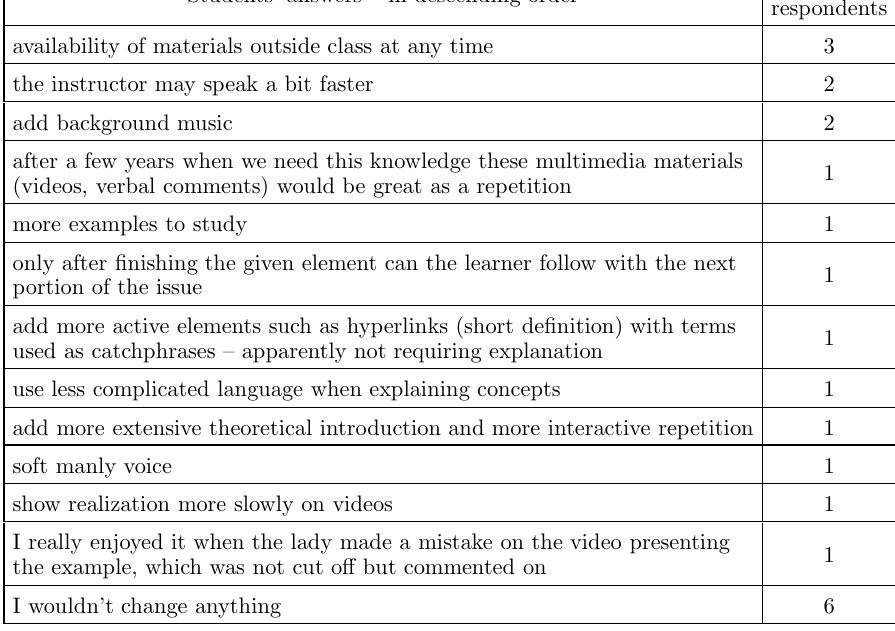
Table 5. Distribution of students’ answers to the open-ended question “What would you change in the form/content of the presented issues to facilitate understanding of the topic more? What should be changed/added to the